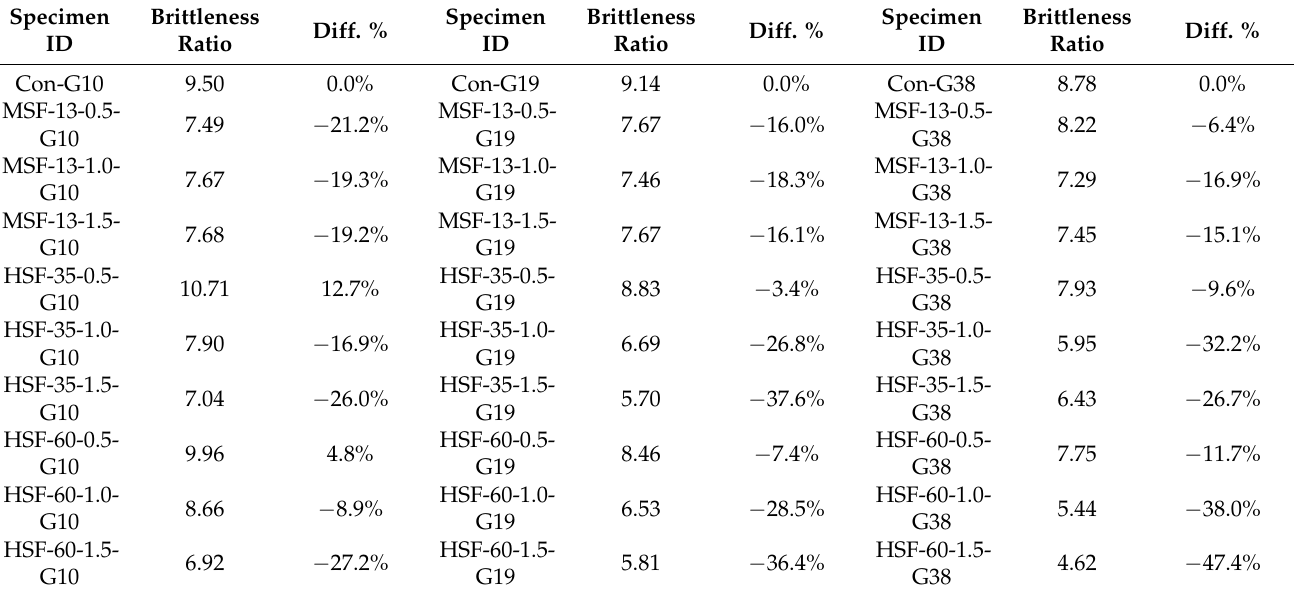
Table 8. Brittleness ratio of synthetic/steel